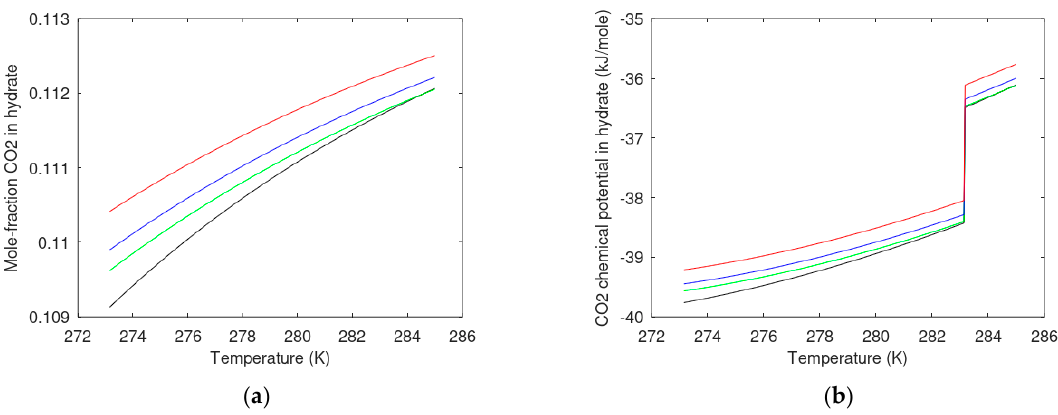
Figure 4. ( a ) Mole-fraction CO 2 in CO 2 hydrate formed from CO 2 and water containing ethanol. Black curve is for 0 mole-fraction ethanol, green curve is for 0.015 mole-fraction ethanol, blue curve is for 0.02 mole-fraction ethanol, and red curve is for 0.03 mole-fraction ethanol. ( b ) Chemical potential for CO 2 in CO 2 hydrate formed from CO 2 and water containing various concentrations of ethanol. Color codes are the same as in Figure 4a.